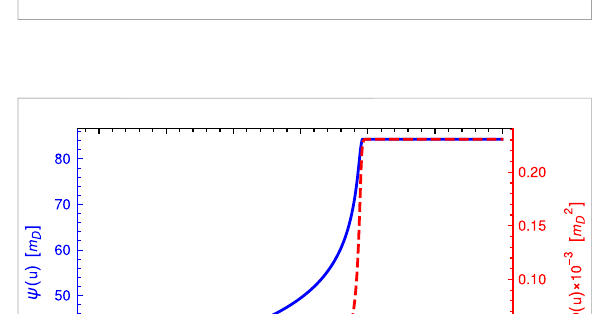
FIGURE 2 FIGURE 4 Graph of the potential term ~ V ( ψ ) of the effective theory (10) Energy density (13) pro fi le along the radial coordinate u for for the parameters chosen in Figure 1. The right minimum is at the solution shown in Figure 3. In the case of spherical symmetry, ψ = − ∞ ,butfor ψ the domain wall forms a bubble with surface energy density σ ≈ 5 · min =84.3.Strictlyspeaking,theleftminimumisat this illustration, a very accurate approximation ψ = 0 is 10 – 9 and wall thickness δ ≈ 1.2 · 10 11 , according to (14), suf fi cient (corresponding to ϕ = ϕ 0 ), up to which the effective theory (6) still works. The maximum value of the potential in the (cid:6) (cid:5)(cid:5)(cid:5)(cid:5)(cid:5)(cid:5)(cid:5)(cid:5)(cid:5) transition region between vacuums used ~ V max ≈ 4 . 1 · 10 − 20 andthe ~ V ′′ ( ψ ) (cid:1) 2 . 7 · 10 − 11 . steepness of the slope used max